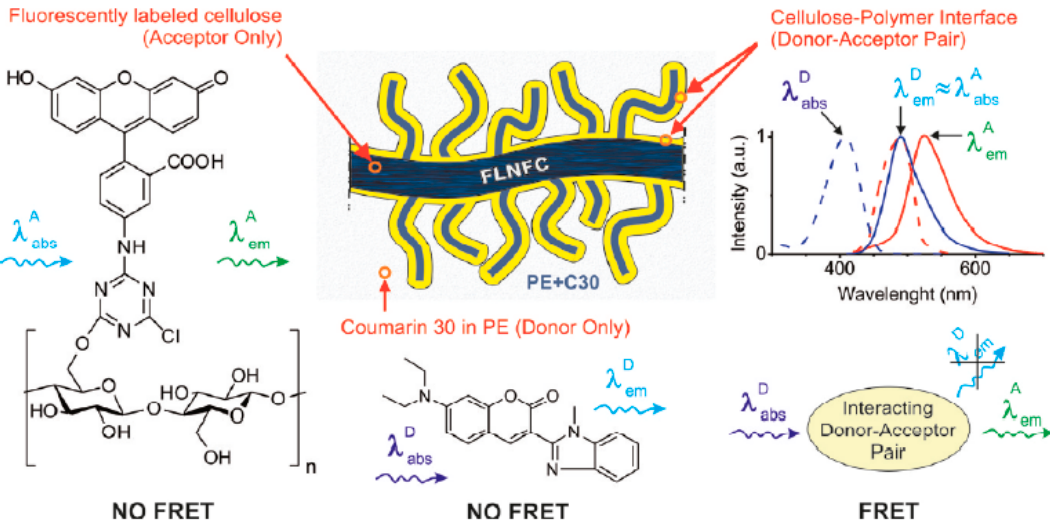
Figure 1. Schematic drawing illustrating the use of FRET for revealing the interface in polymer composites. Reprinted from reference [43] with permission from ACS Publications.